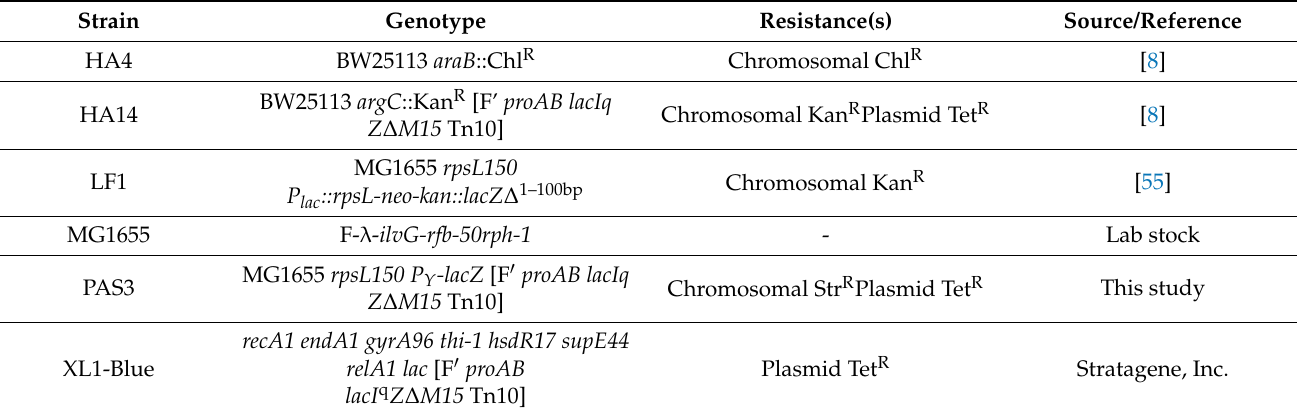
Table 2. Strains used in this